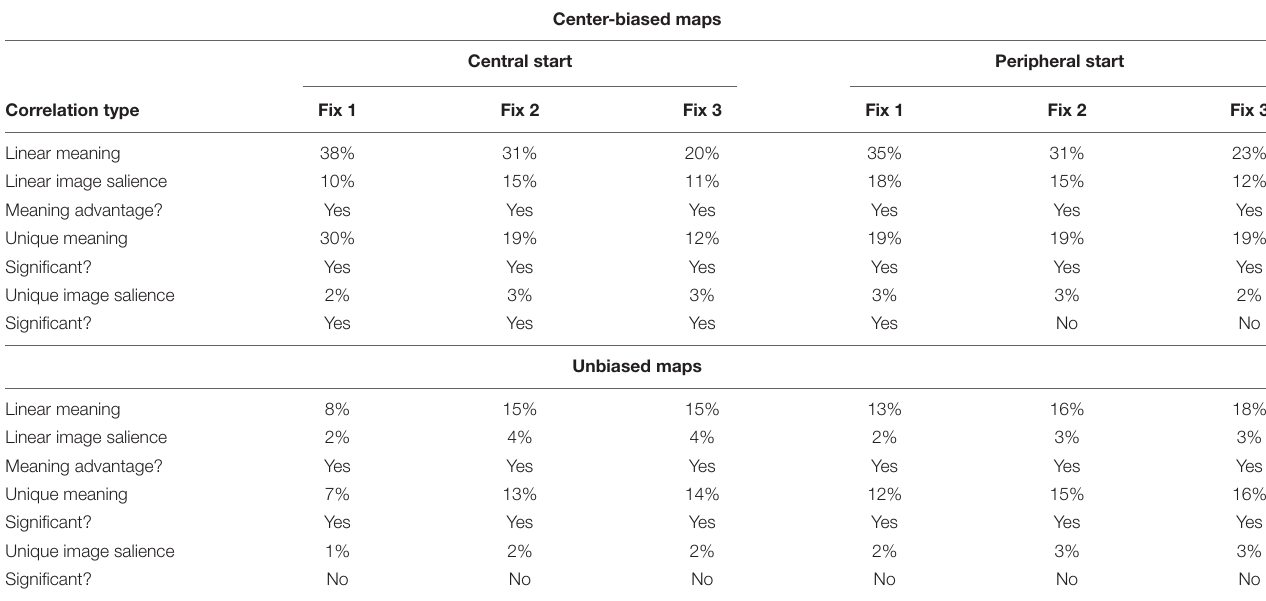
TABLE 2 | Comparison between peripheral start (current study) and central start (Peacock et al., 2019b) experiments using meaning (percentage of variance explained) and saliency (percentage of variance explained) to predict early